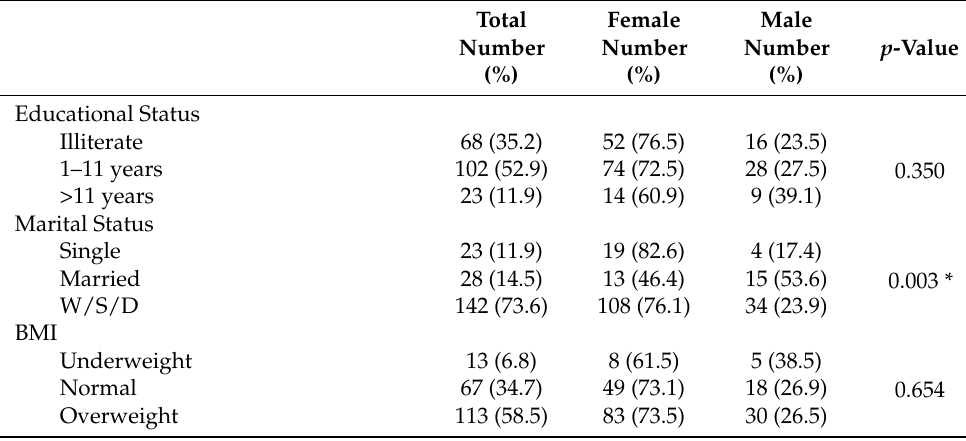
Table 1. Main baseline characteristics of the study population by gender (N =